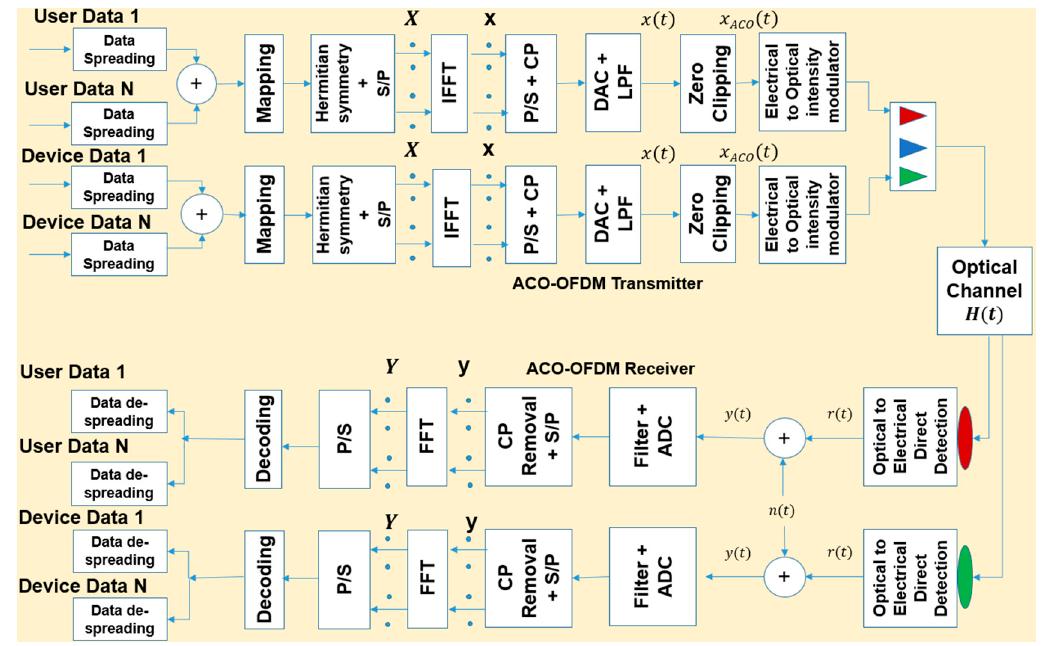
Figure 2. Block diagram of the downlink section. S/P: serial to parallel; IFFT: inverse fast Fourier transform; P/S: parallel to serial; CP: cyclic prefix; DAC: digital-to-analogue converter; LPF: low pass filter; ACO-OFDM: asymmetrically clipped optical orthogonal frequency-division multiplexing; and ADC: analogue-to-digital converter.